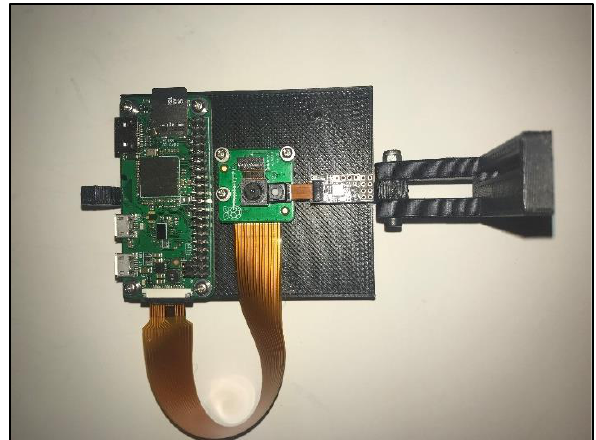
Figure 7 . Top, from left: RefImage, Im02. Bottom, from left: Im03, Im04. Im01 is not displayed as it is identical to the RefImage.